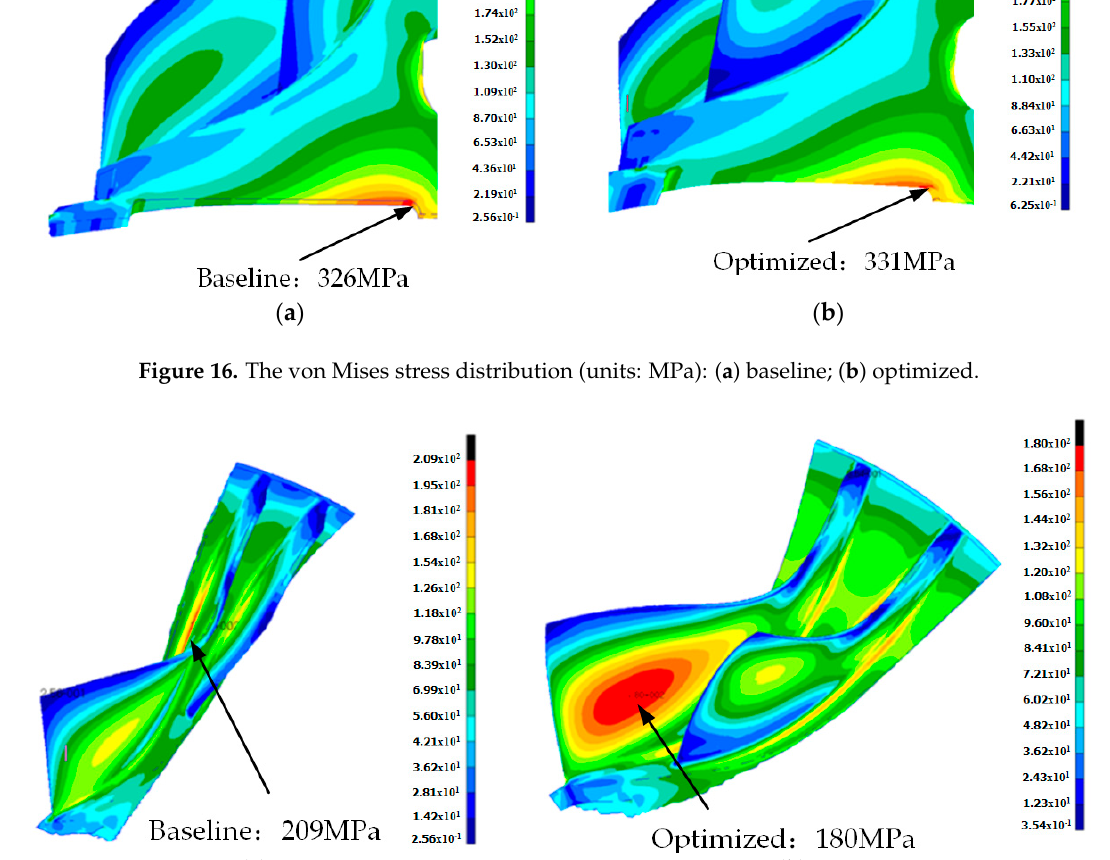
Figure 17. The von Mises distribution of blades (units: MPa): ( a ) baseline; ( b ) optimized.